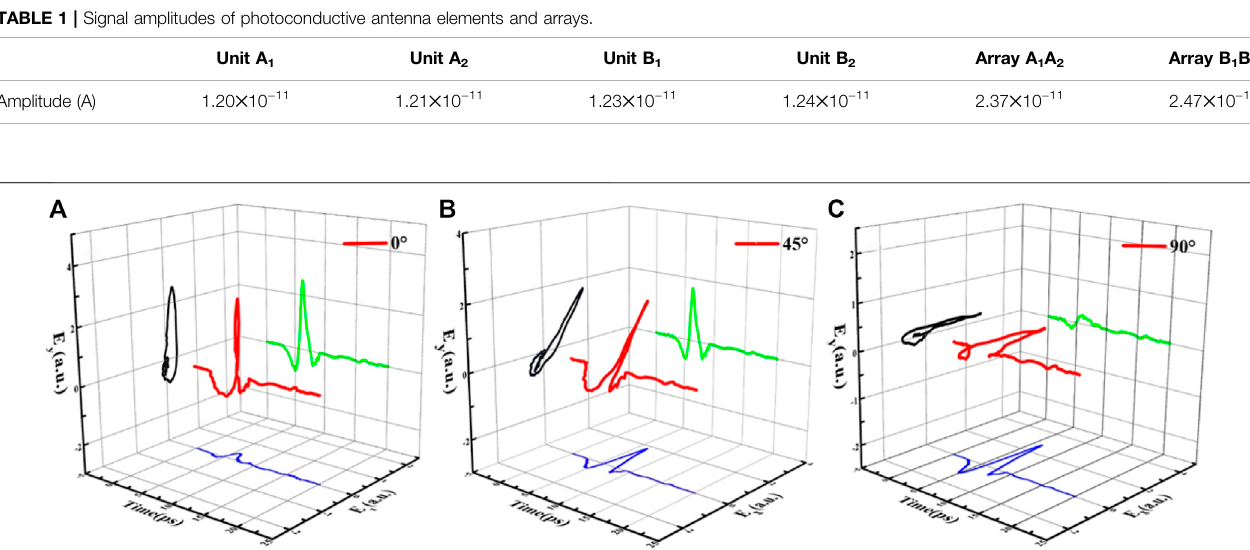
FIGURE 3 | THz time-domain signal of photoconductive antenna array detector at angles (A) θ = 0 ° (B) θ = 45 ° and (C) θ = 90 ° .